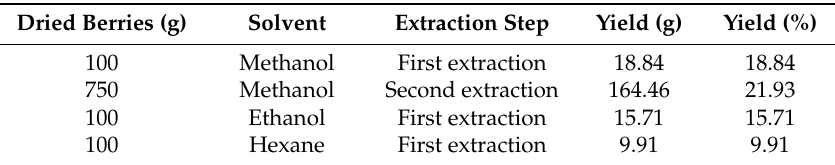
Table 1. Yield of P. cubeba L. extracts in different